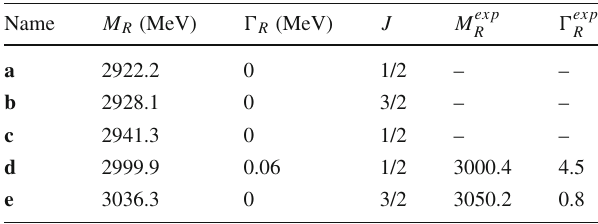
Fig. 1 (cid:2) c ( J = 1 / 2 ) an (cid:2) ∗ c ( J = 3 / 2 ) odd-parity states, reported in Ref. [38], coming from the most attractive SU ( 6 ) lsf × HQSS represen- tations.Thesefivestates,denotedasinTable1,arelocatedbelow3GeV for J = 1 / 2 (upper plot) and J = 3 / 2 (lower plot), while the five heav- ier resonant states above 3 GeV, also shown, come from less attractive SU ( 6 ) lsf × HQSS multiplets, stemming from the exotic 4752 SU(8) representation. Since the dynamically generated states may couple dif- ferently to their baryon-meson components, we show the ij − channel (cid:19) | T J ( z ) | , which allows us to independent quantity | ˜ T ( z ) | J = max j i ij identify all the resonances within a J − sector at once. The blue dots cor- respond to the experimentally observed states. We display them both in the upper and lower plots because their spin is not determined Table 2 (cid:2) c and (cid:2) ∗ c states obtained using α = 1 .